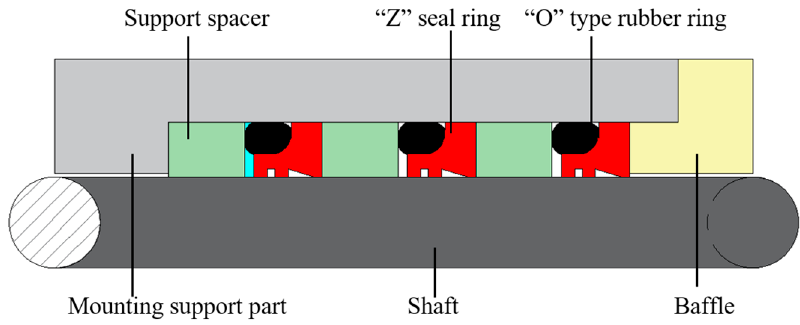
Figure 8. Ultrahigh-pressure rotary dynamic sealing structure.